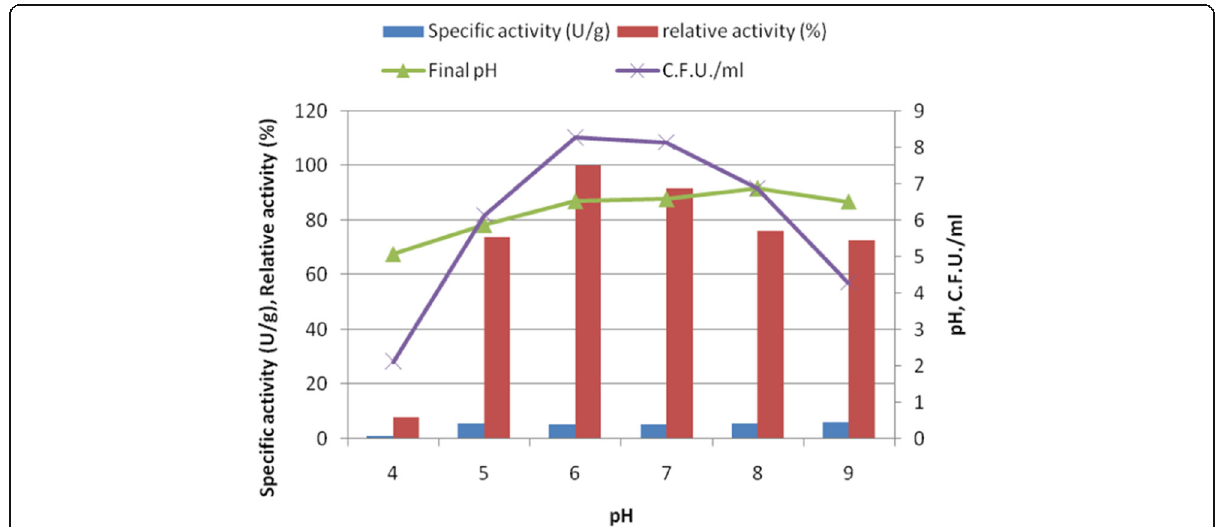
Fig. 2 Effect of pH on specific and relative activity of chitinase produced by S . maltophilia JF66 following 5 days of incubation at 37 °C and 140 rpm